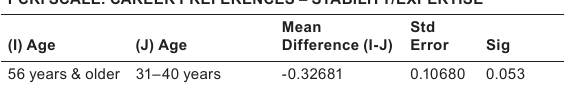
Table 6 Summary of Scheffé multiple comparison tests: Significant group mean differences on career preferences scale (N = 2 997)